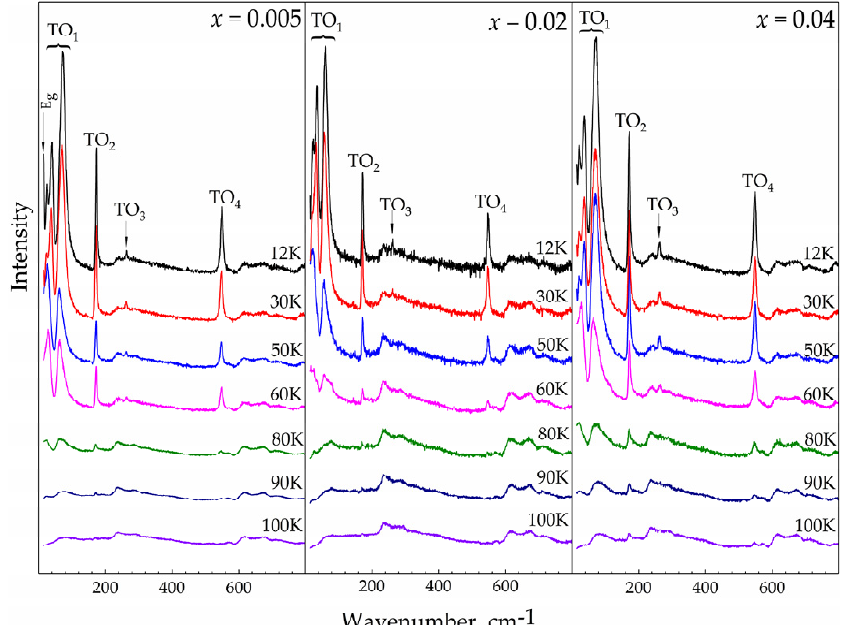
Figure 1. Temperature-dependent Raman spectra of the Sr 1 − x Pb x TiO 3 solid solutions at concentra- tions x = 0.005, 0.02, 0.04 in the temperature range 12–100 K. Upon cooling, the Raman spectra of the PST x reveal the wing of the low-frequency line centered at the frequency below 15 cm − 1 in the temperature range of 90–12 K (see Figure 1). This line can be attributed to the E g mode, which also indicates a structural phase transition at 90 K. The same mode was observed by Taniguchi et al. [31] in the Note that the frequency and intensity of the E g mode increased upon